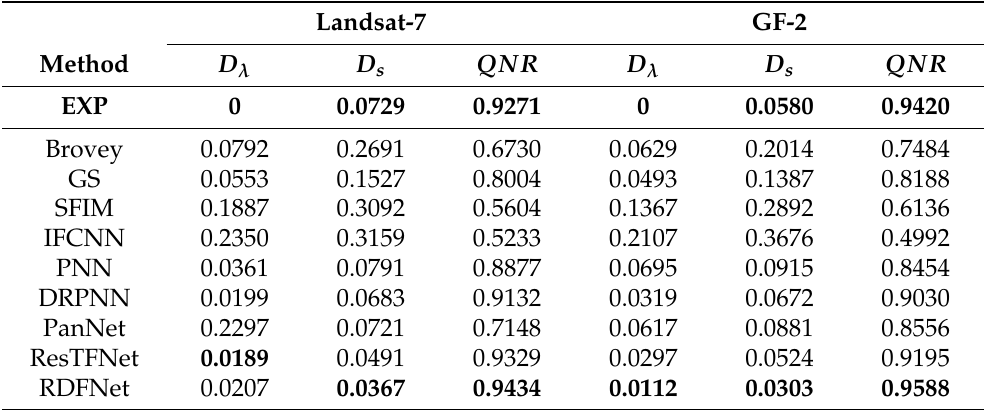
Table 3. Quantitative indicators of Landsat-7 and GF-2 fusion results with full resolution.